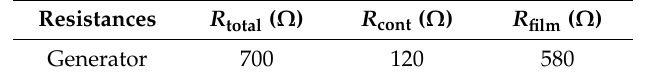
Table 2. Total, contact, and film electrical resistances of the thin-film thermoelectric generator. Resistances R total ( Ω ) R cont ( Ω ) R film ( Ω ) Resistances Generator 700 120 580